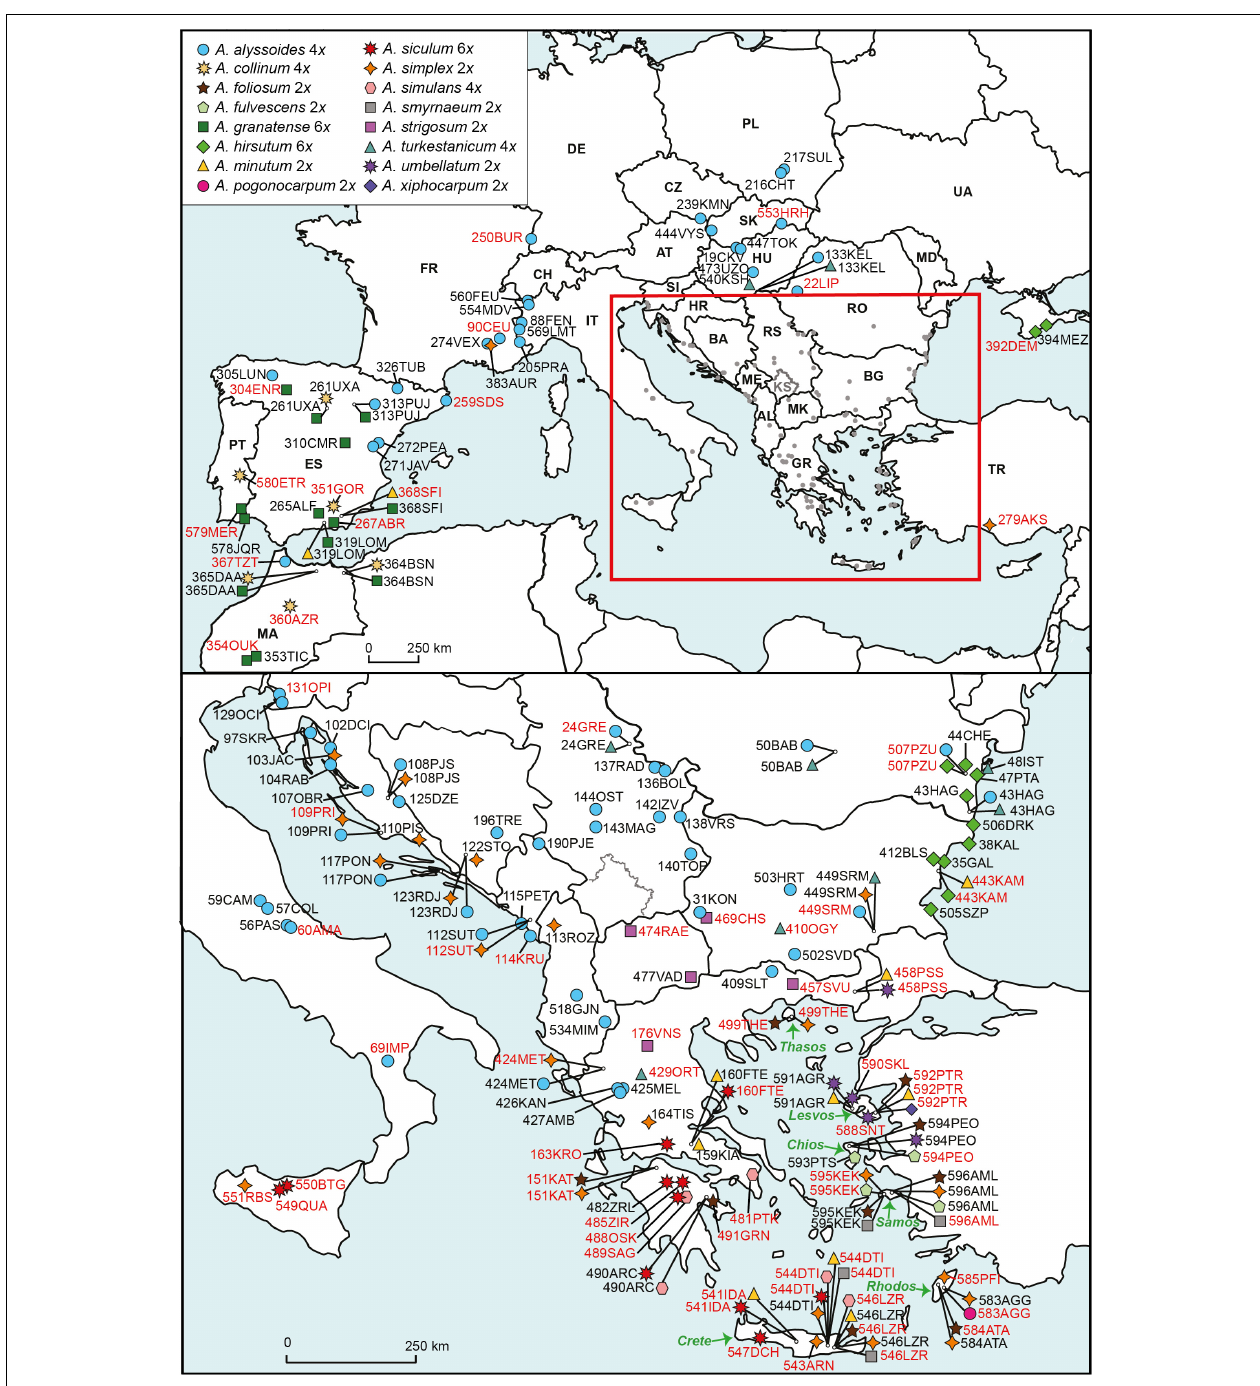
FIGURE 1 | Map of the sample sites of the analyzed annual Alyssum species. Population assignments to the species are indicated by different symbol colors and shapes. Ploidy levels are indicated next to the species names. Alyssum szovitsianum, which was represented by one population sample (289TRJ- sz ) from Iran, is not shown on the map. Population codes follow Supplementary Table 1 and are written in either black script (population samples used only for the FCM analyses) or red script (population samples used for both FCM and molecular analyses).